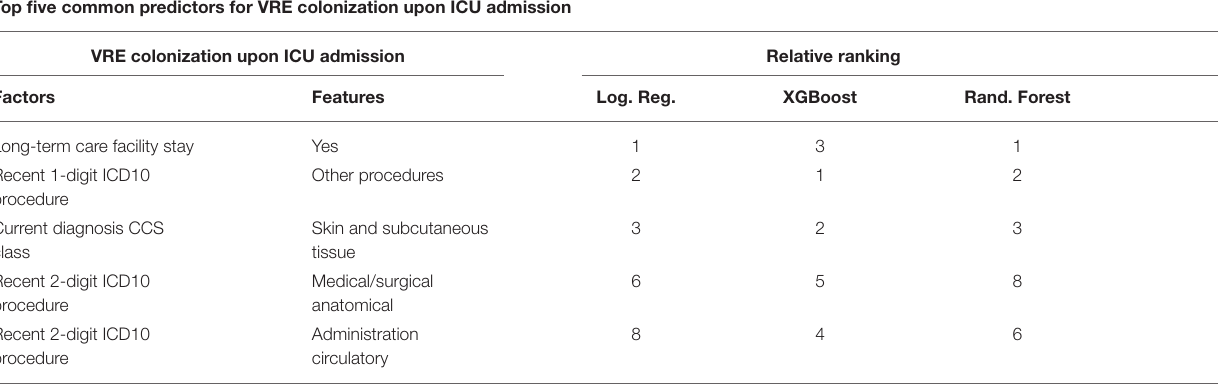
TABLE 6 | Top five common predictors for VRE, CRE, MRSA, and MDRO colonization identified by the machine learning models. Top five common predictors for VRE colonization upon ICU